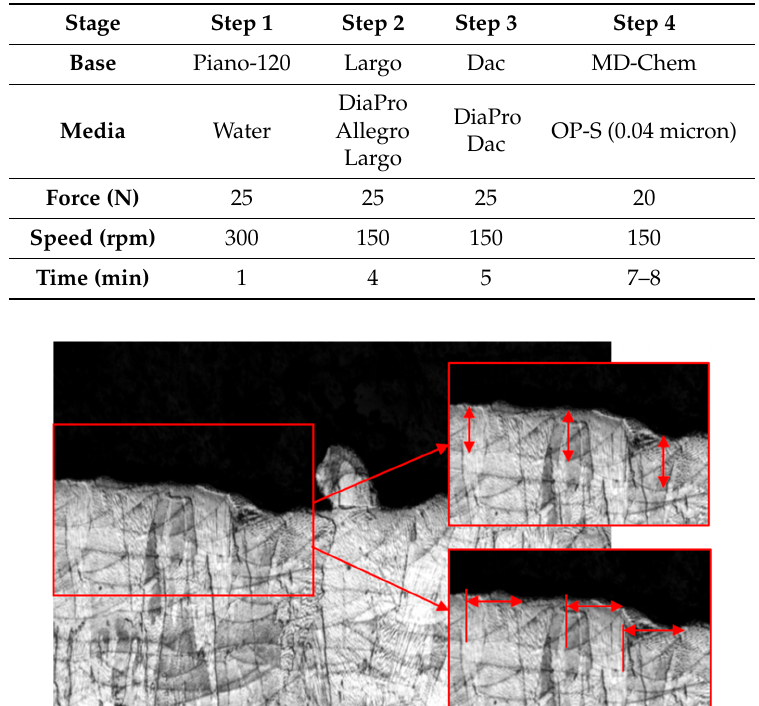
Table 2. Standard metallurgical preparation procedure for nickel-based superalloys.